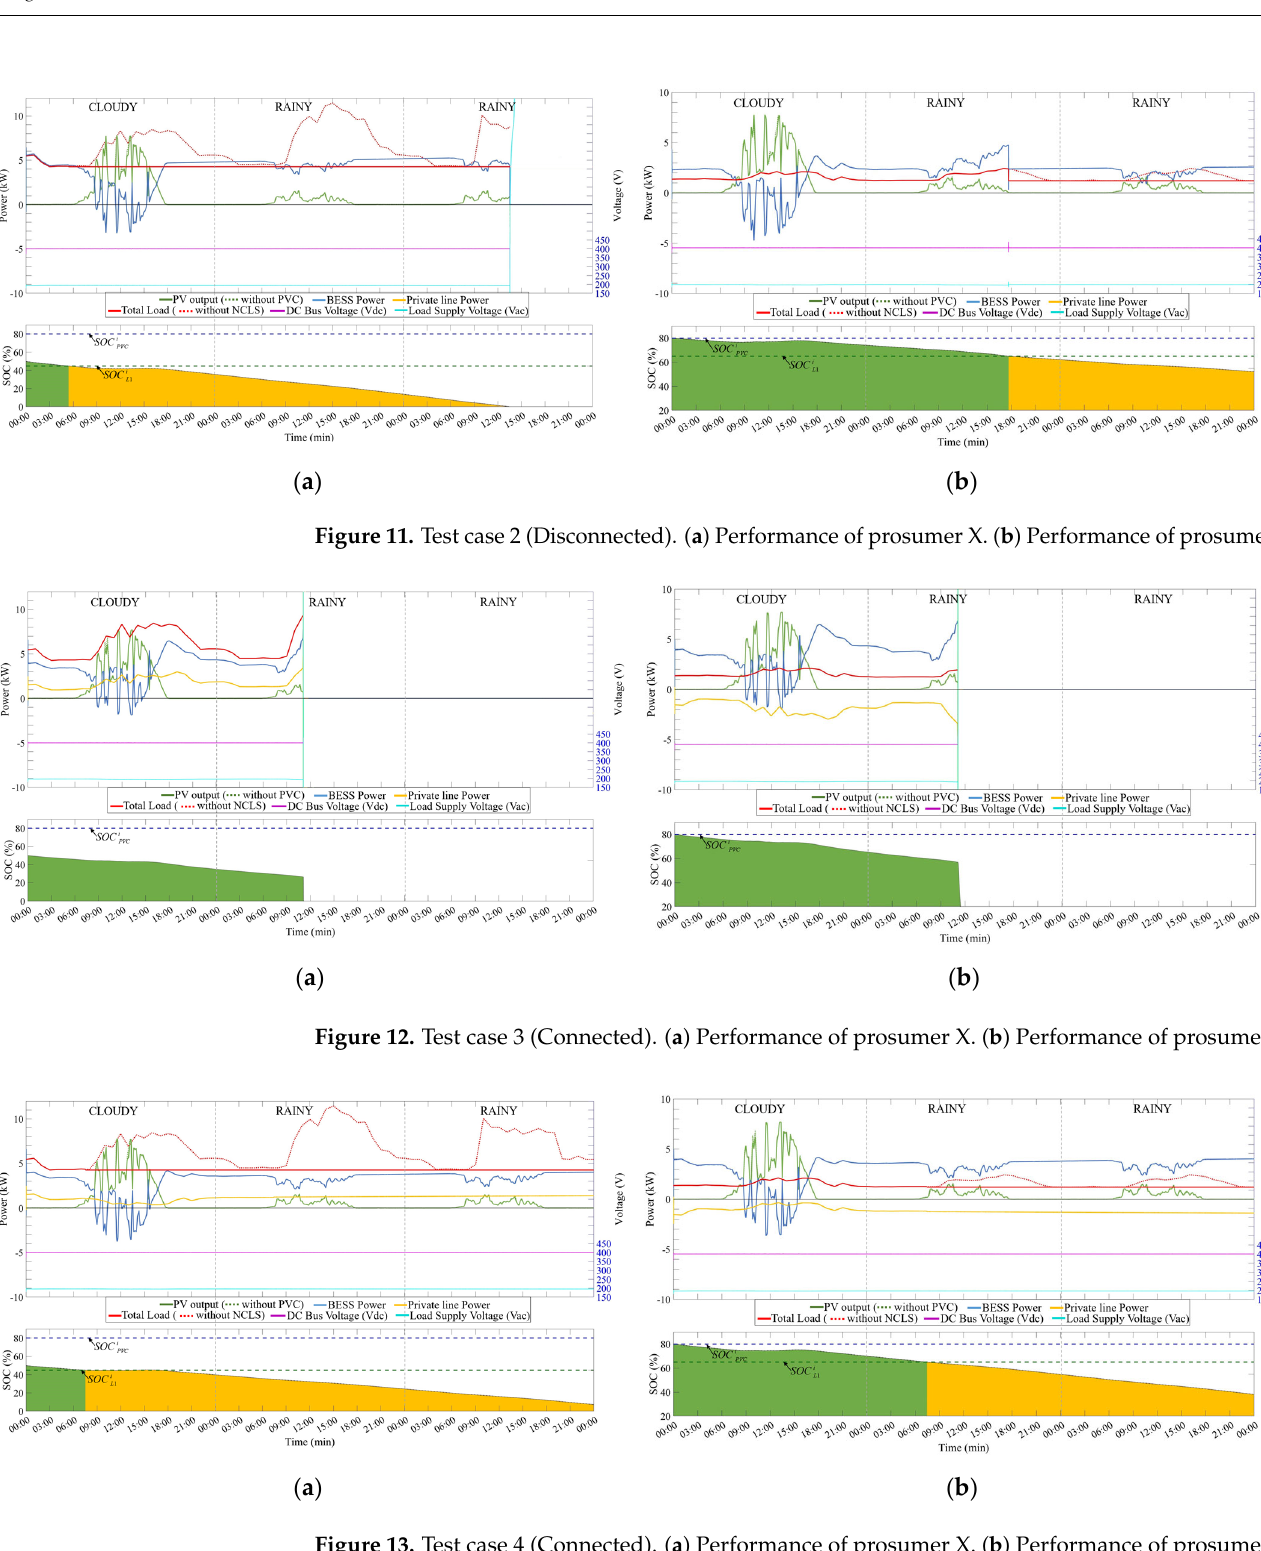
Figure 12. Test case 3 (Connected). ( a ) Performance of prosumer X. ( b ) Performance of prosumer